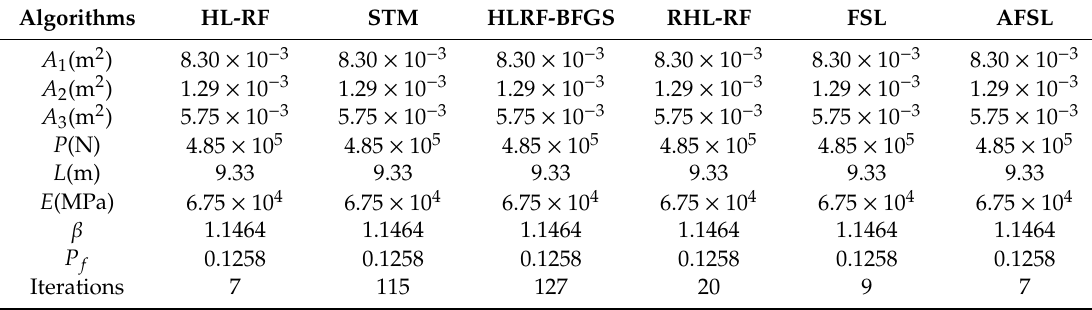
Table 5. Convergent results of di ff erent algorithms for Example